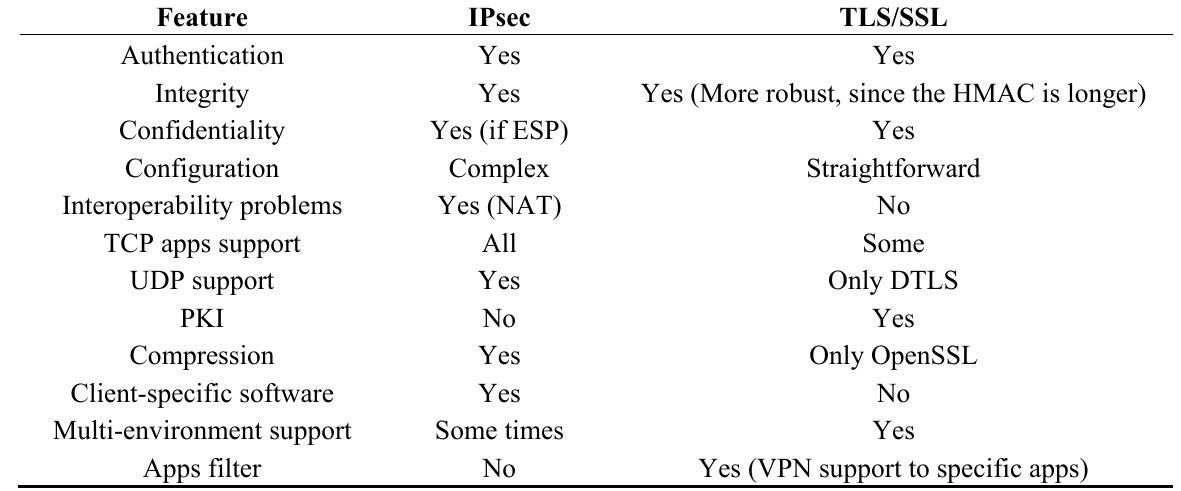
Table 4. Summary of IPSec and TLS/SSL technical